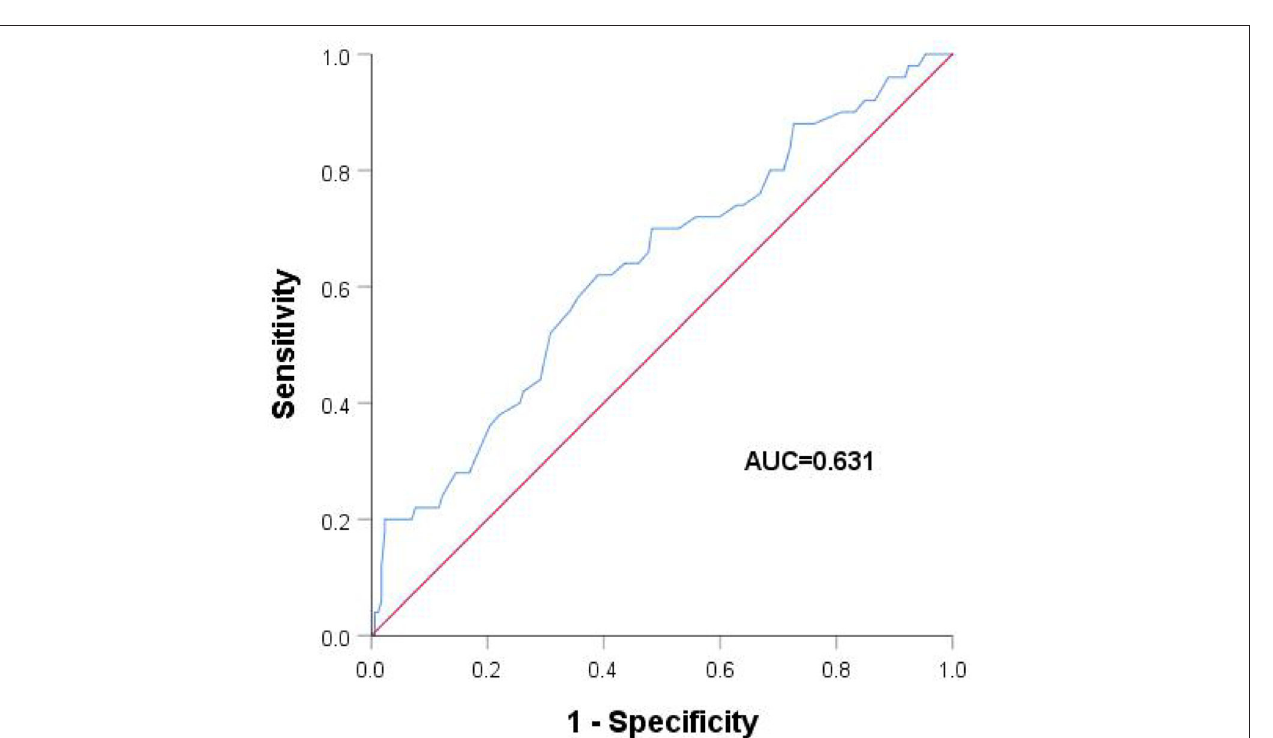
Frontiers in Cardiovascular Medicine |